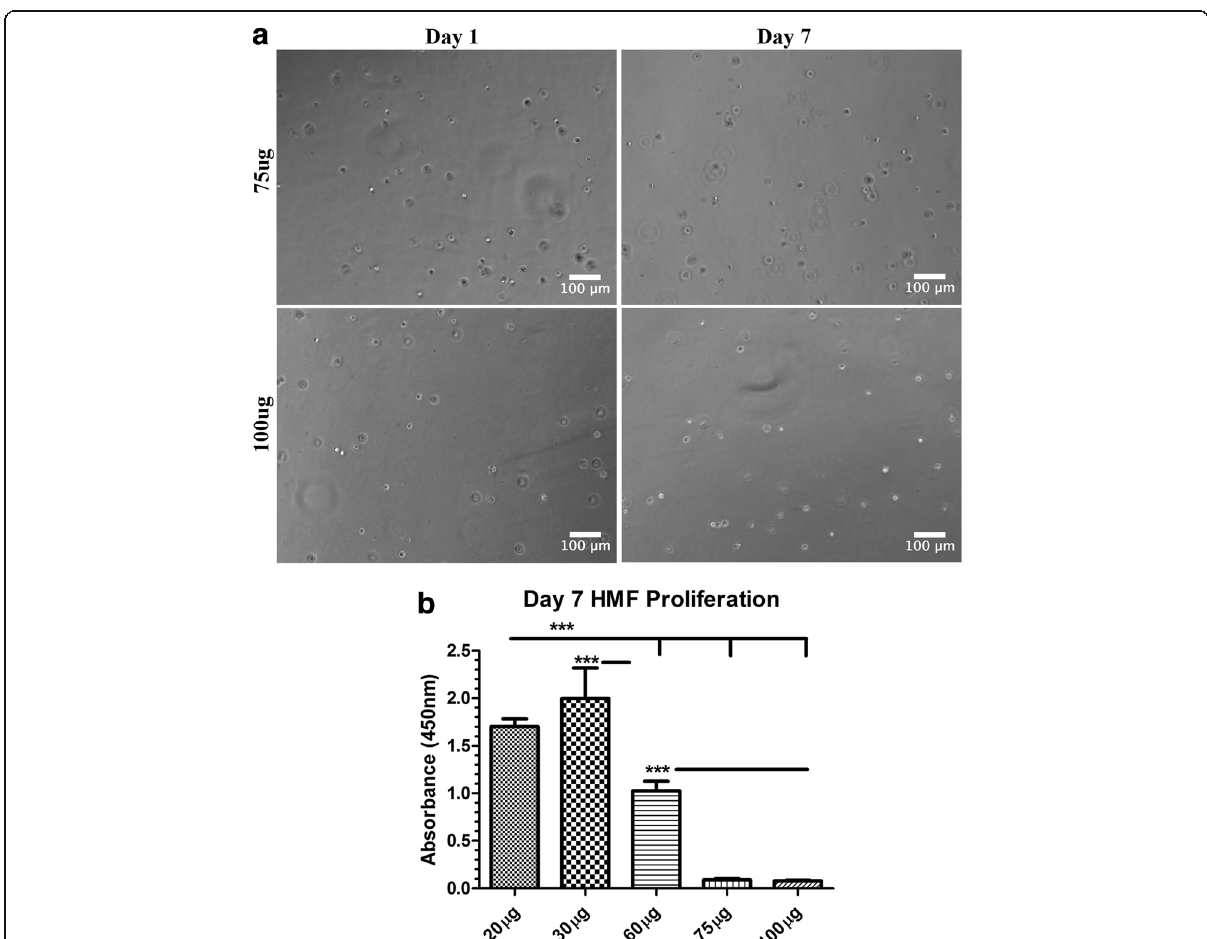
Fig. 4 HMF morphology and proliferation in 75 and 100 μ g/ml mTG hydrogels. a HMFs were encapsulated in 75 and 100 μ g/ml mTG hydrogels and allowed to incubate for 7 days. HMFs displayed a rounded morphology at days 1 and 7 in culture. b HMFs encapsulated in mTG cross-linked hydrogels were examined for changes in proliferation at day 7 of culture. HMFs in 75 and 100 μ g/ml mTG hydrogels exhibited a significant decrease in proliferation in comparison to HMFs in compliant, moderate and stiff hydrogels. HMFs in the moderate hydrogels exhibited the most significant change in proliferation. * p ≤ 0.05; ** p ≤ 0.01; *** p ≤